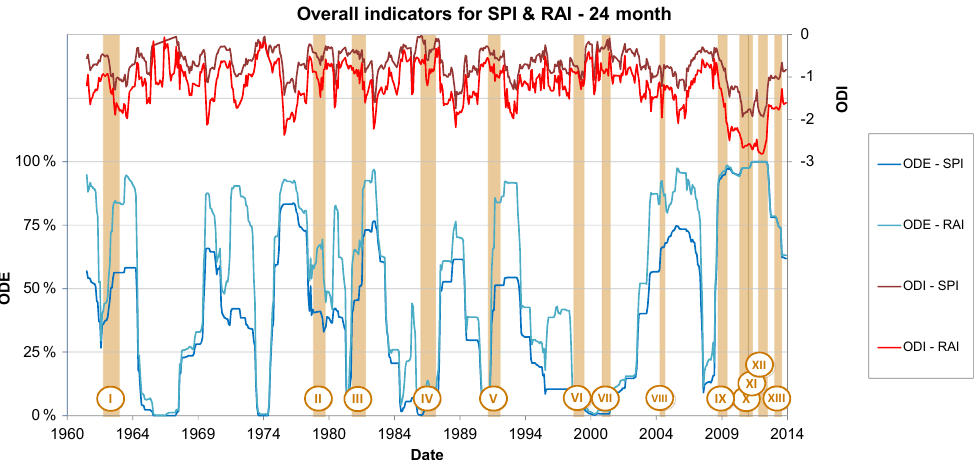
Figure A9. ODE and ODI values using the 24-month timescales of SPI and RAI indices, compared with the 13 detected historical droughts (in orange).